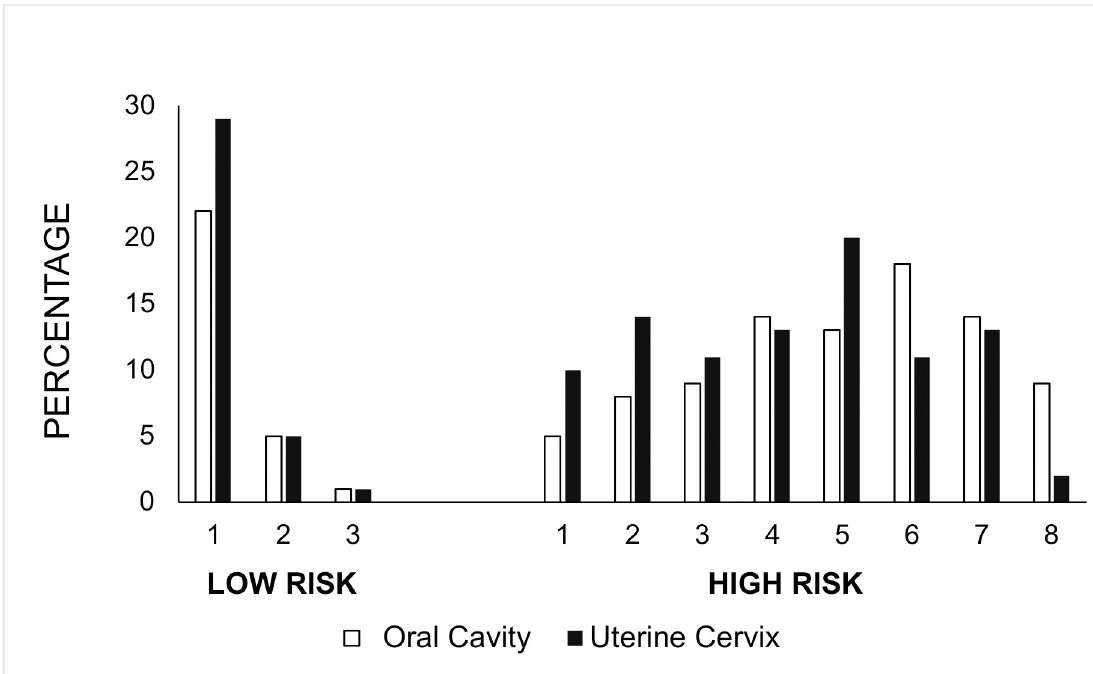
Fig 2. Graphical representation of the percentage of viral types present in patients. The number of types detected in the uterine cervix (black bars) and oral cavity (white bars) is